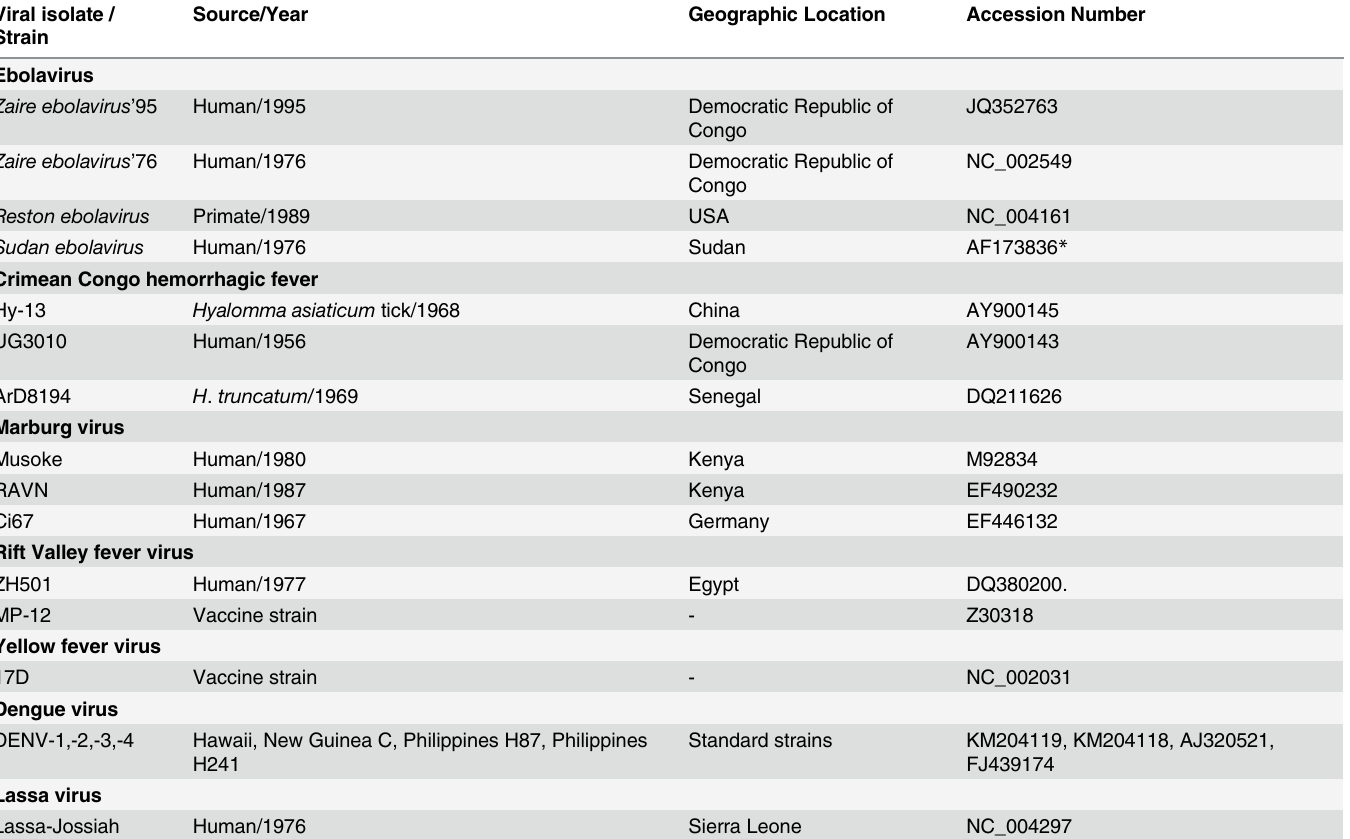
Table 1. Details of viral cultures and nucleic acids used in the study: RNA